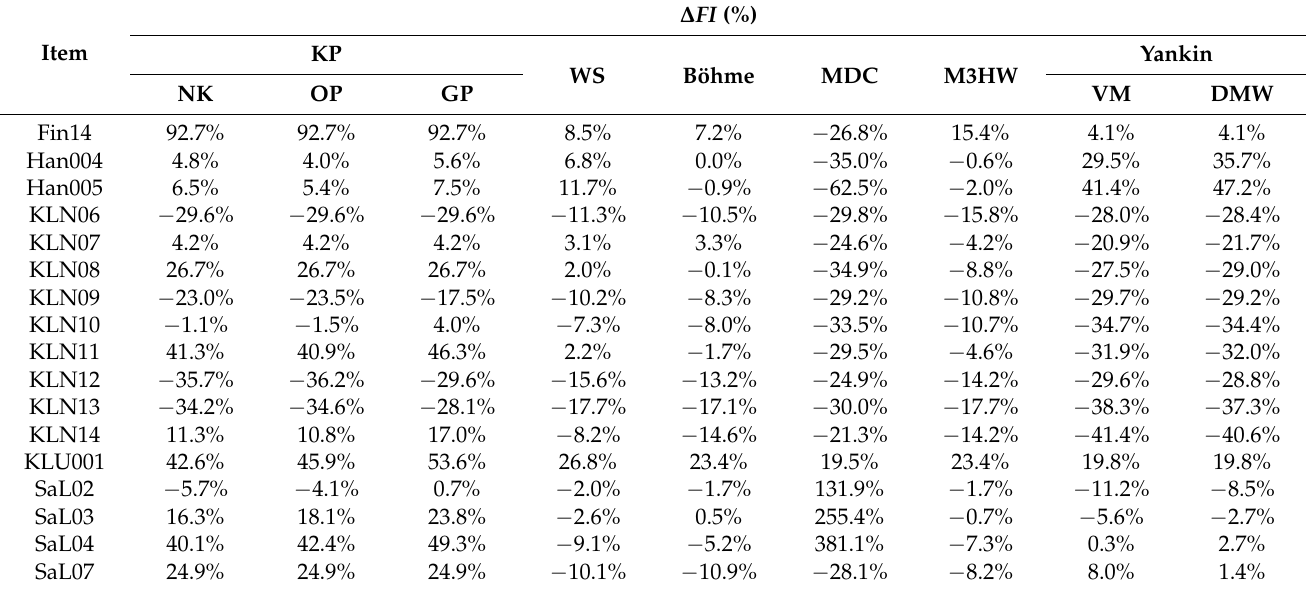
Table 7. The response of the new multiaxial fatigue strength criteria evaluated to the cases of plane bending-torsion load from the AMSD25 data set.